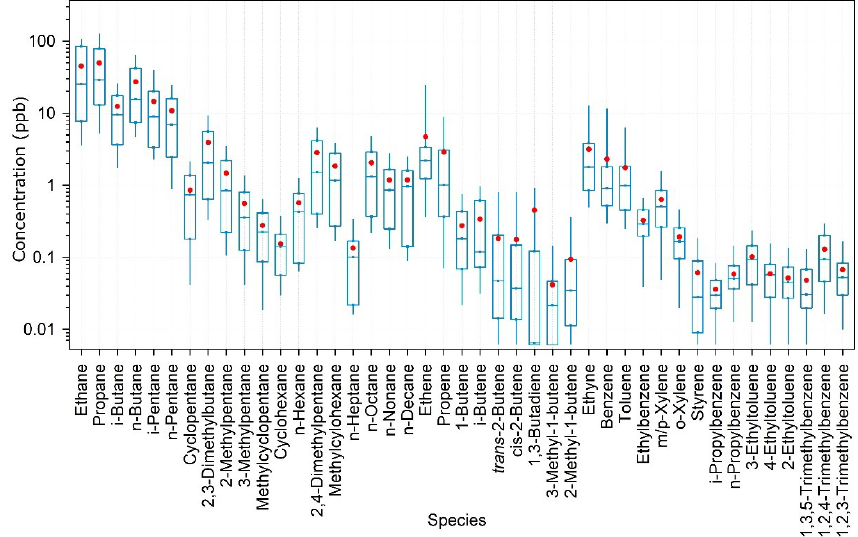
Figure 5. VOC source profile of the oil field emissions in the YelRD region. The box plot provides the 10th, 25th, 50th, 75th, and 90th percentiles of the source sample data, and the red dot gives the average of the data. Note that the regional background has been subtracted from the source data.